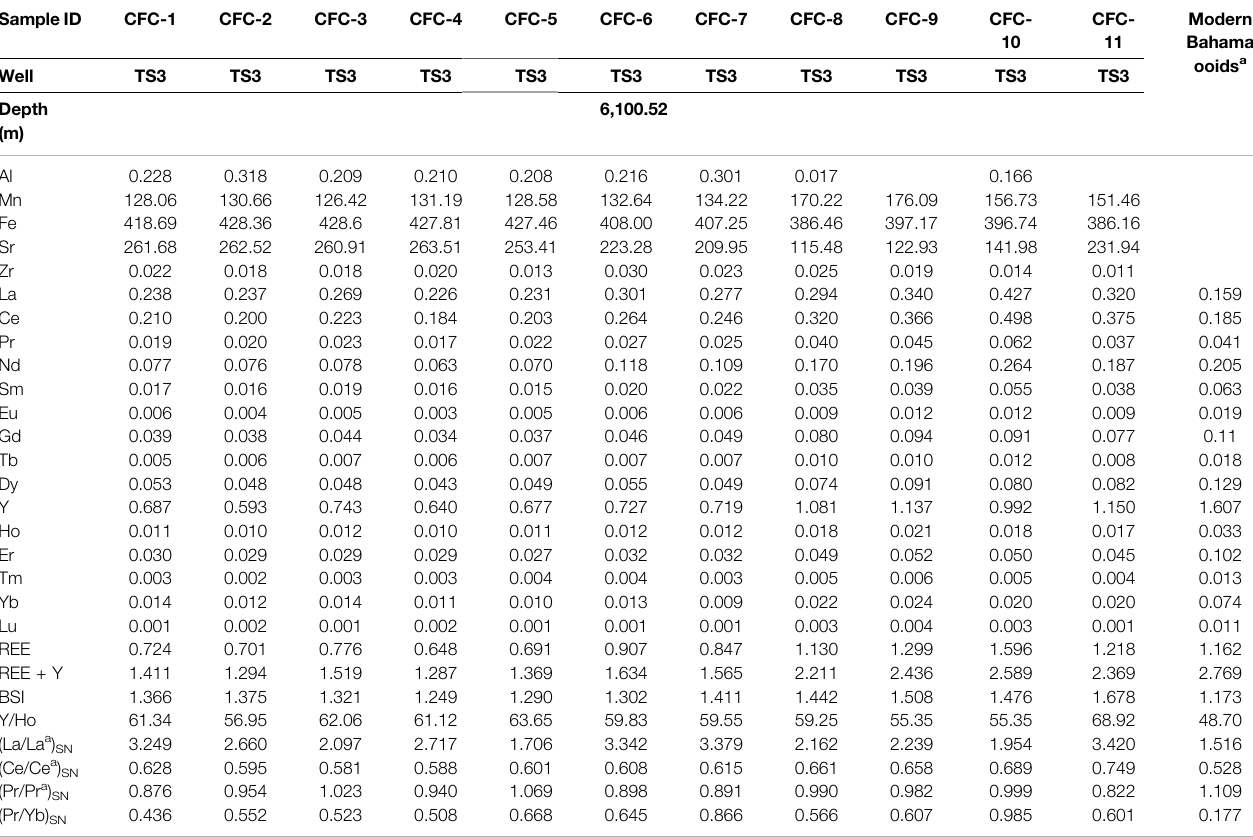
TABLE 3 | In situ rare earth elements and yttrium (REEY) concentrations (in ppm) of CFC samples and modern Bahama ooids (from Li et al.,